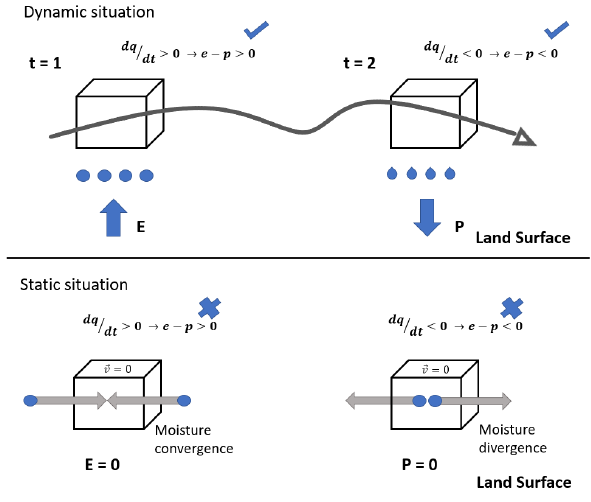
Figure 10. Schematic representation of the problem with conver- gence and divergence of moisture undergone by the FLEXPART-